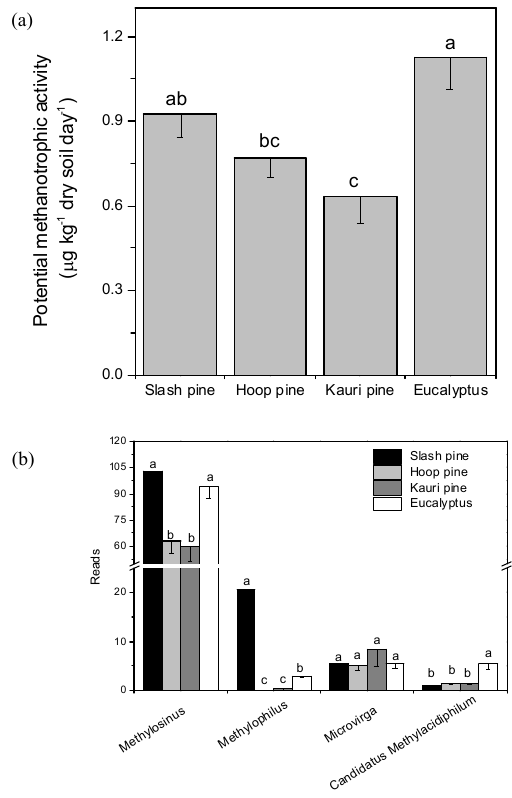
Figure 6. Soil potential methanotrophic activity (a) and methy- lotrophic genus reads detected by high-throughput sequencing (b) under different tree